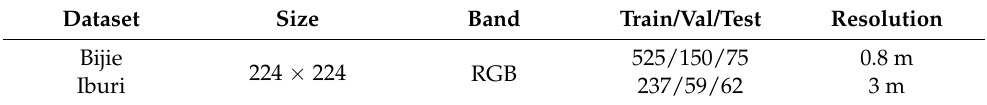
Table 2. Information of the